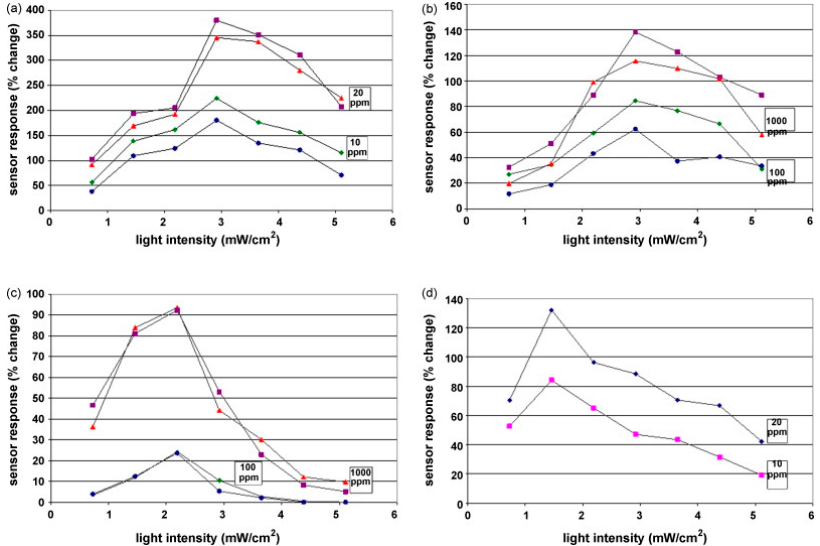
Figure 3. Sensing response (% change in the baseline current) vs. light intensity . Two different sensors based on ZnO were exposed to ( a ) hexane; ( b ) propane; ( c ) methane; ( d ) ethanol vapors of different concentrations. Reproduced with permission from [38].